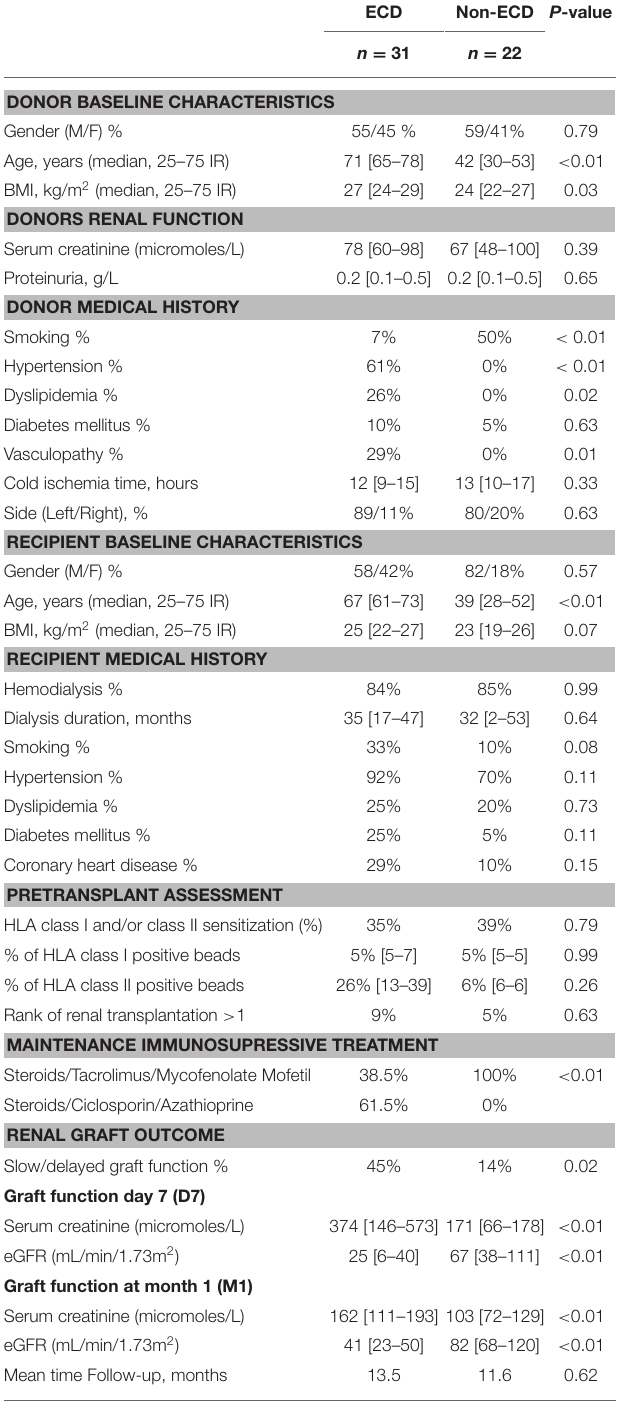
TABLE 1 | Donors and recipients characteristics.